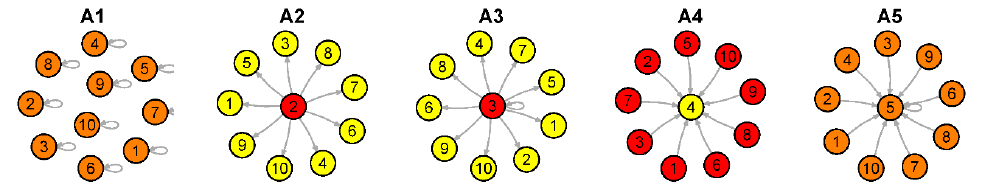
Figure 2. Graphs G ((cid:3036)) with out-degree centralities colored by the yellow-red gradient.